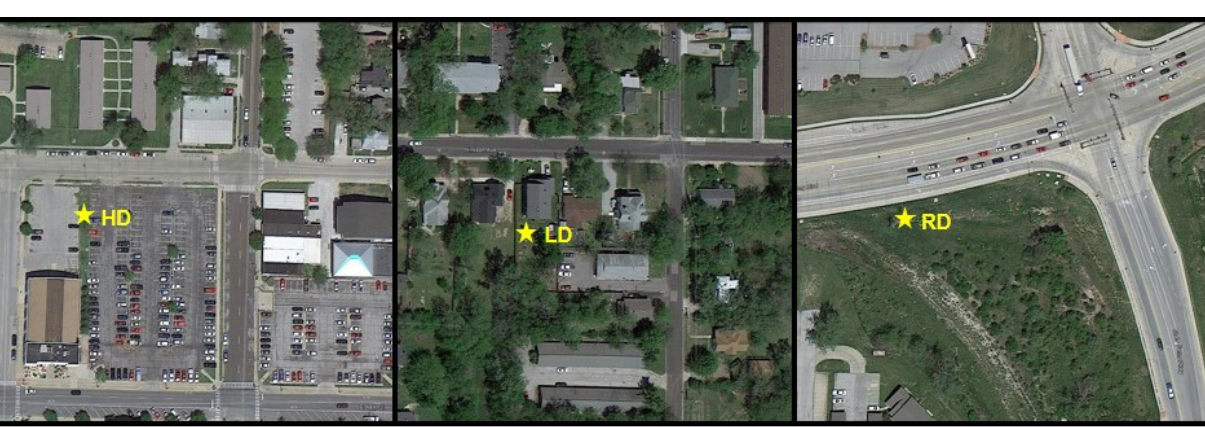
Figure 3. Intra-urban gradient climate monitoring sites located in the City of Columbia, Missouri, USA, representing the complexity and distribution of development. Star indicates meteorological station location. LD = Low Development, HD = High Development, and RD = Recent Development. Google Earth images 450 m above